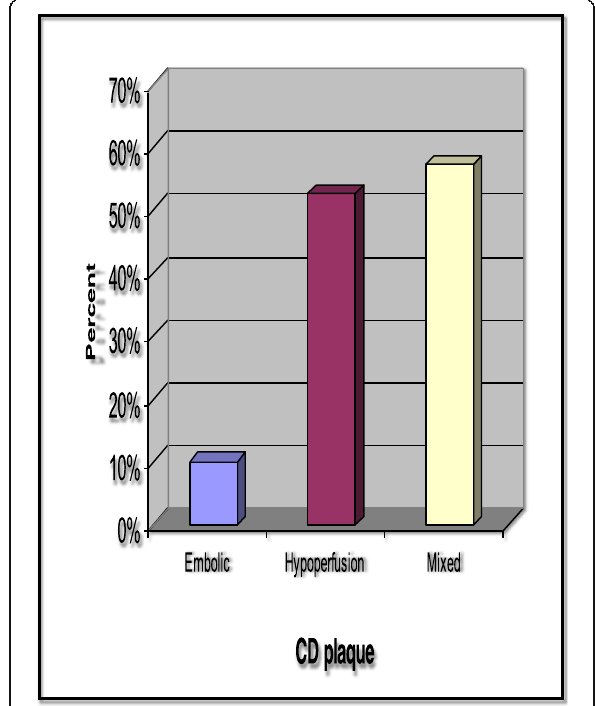
Fig. 2 Carotid duplex plaques. Among the 23 patients who had plaques by carotid duplex in their internal carotid artery, only